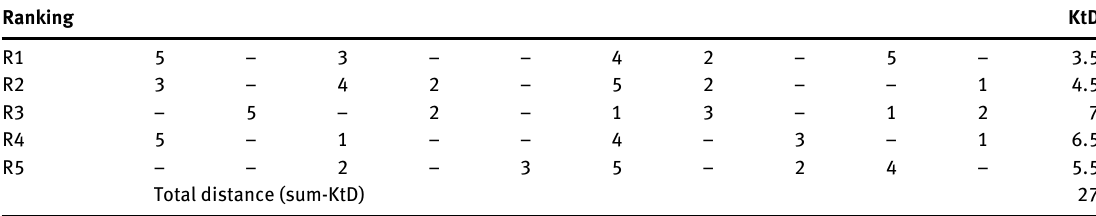
Table 3: Example of Fitness Function (Sum-KtD with Bucket Order).